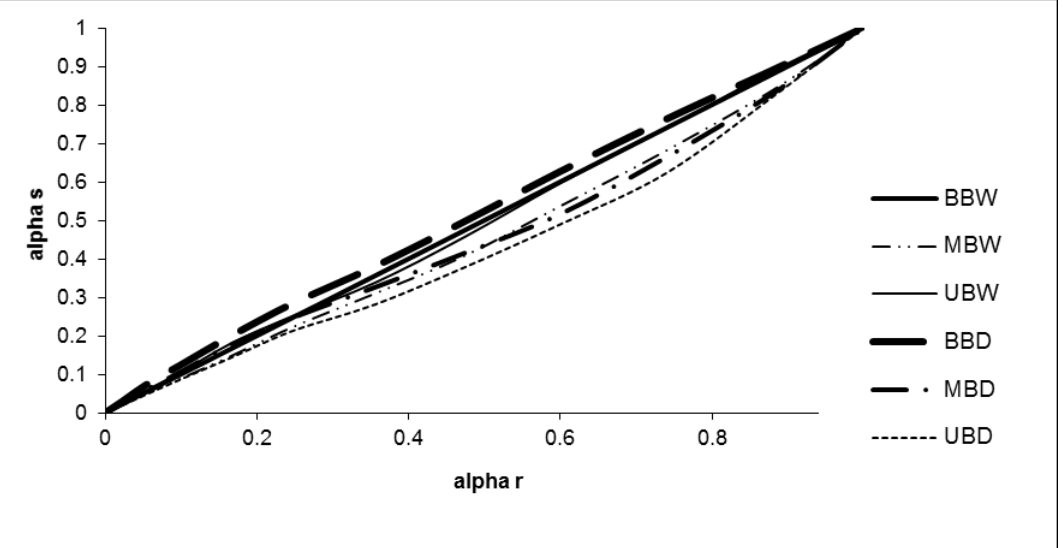
Figure 11. Alpha s–alpha r dependence of okra bast fibers in nitrogen atmosphere.